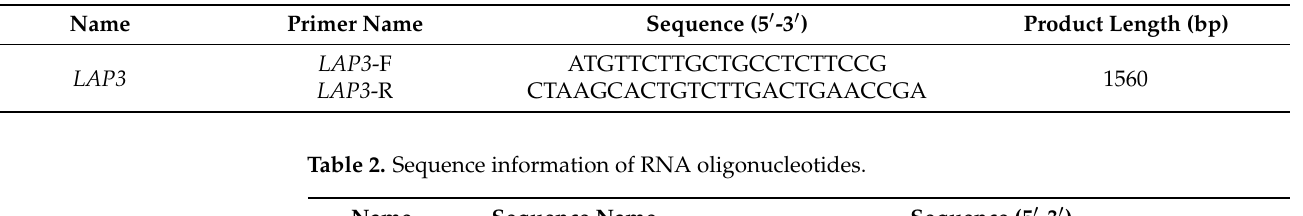
Table 1. Primers used in plasmid construction.